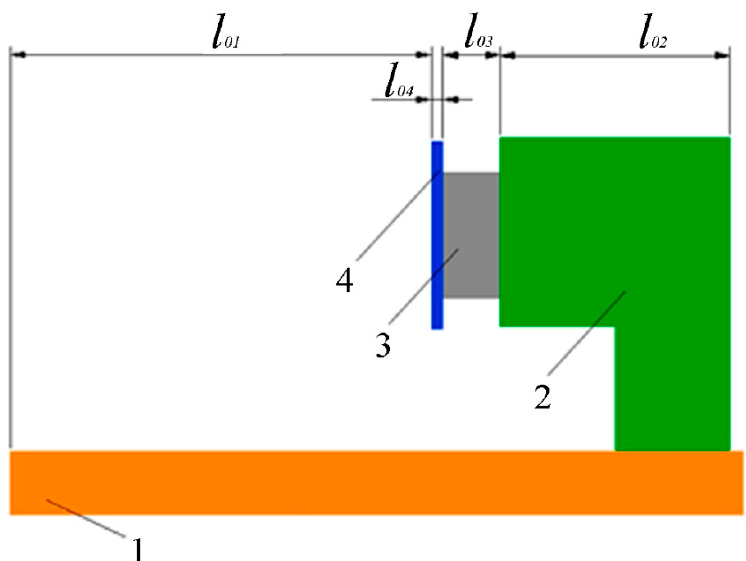
Figure 4. Example of optical bench section. 1—bench ( α 1 ), 2—fasteners ( α 2 ), 3—piezoceramics ( α 3 ), 4—mirror ( α 4 ).